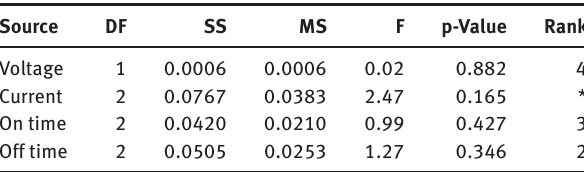
Table 11: Analysis of variance for TWR in the machining of O MMCs. Al/5%Al 2 3